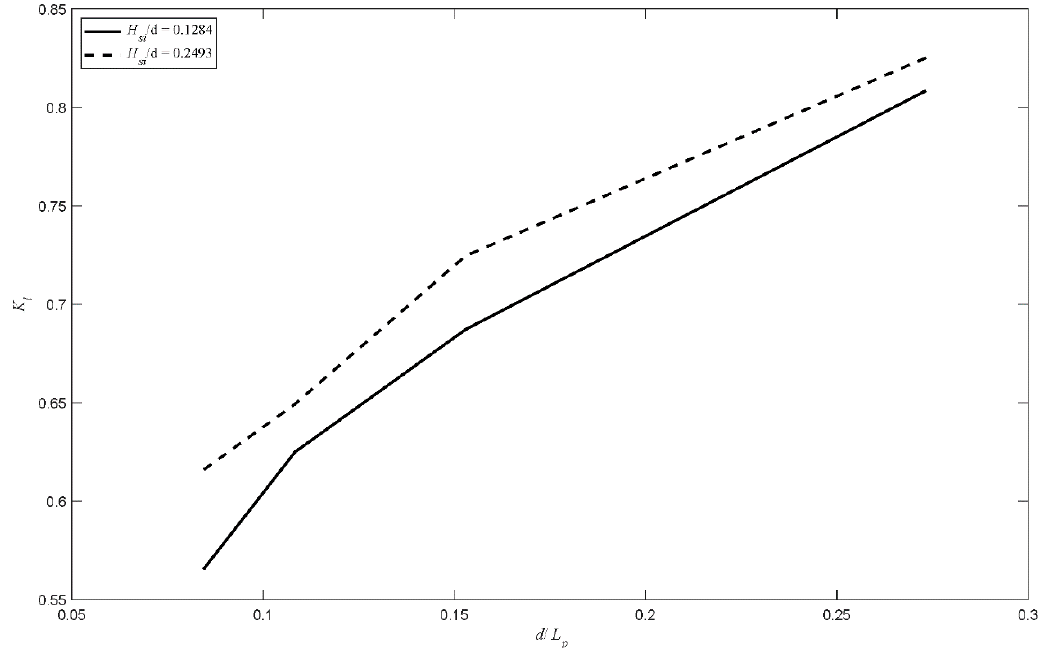
= 2, P = 20%, and θ = 90 ◦